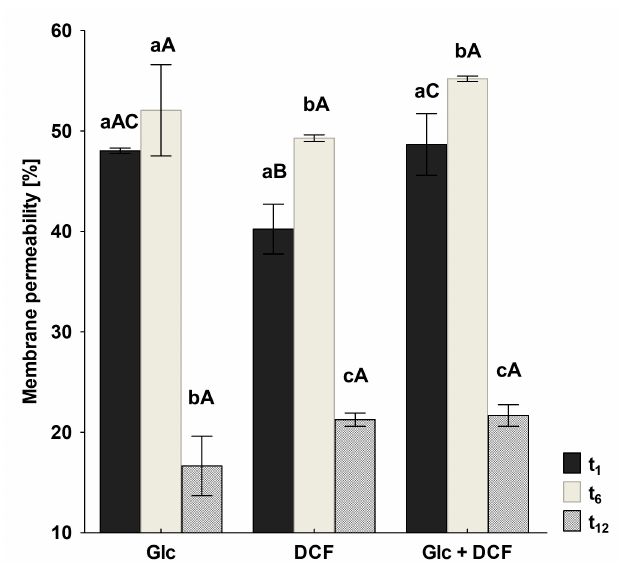
Figure 5. Changes in membrane permeability measured by CV uptake. CV—crystal violet, DCF— diclofenac, Glc—glucose. The data are presented as the mean values of three biological replicates ± standard deviation. a,b,c—statistically significant differences using a one-way ANOVA with a p -value < 0.05 followed by least significant differences (LSD) test for different times; A,B,C—statistically